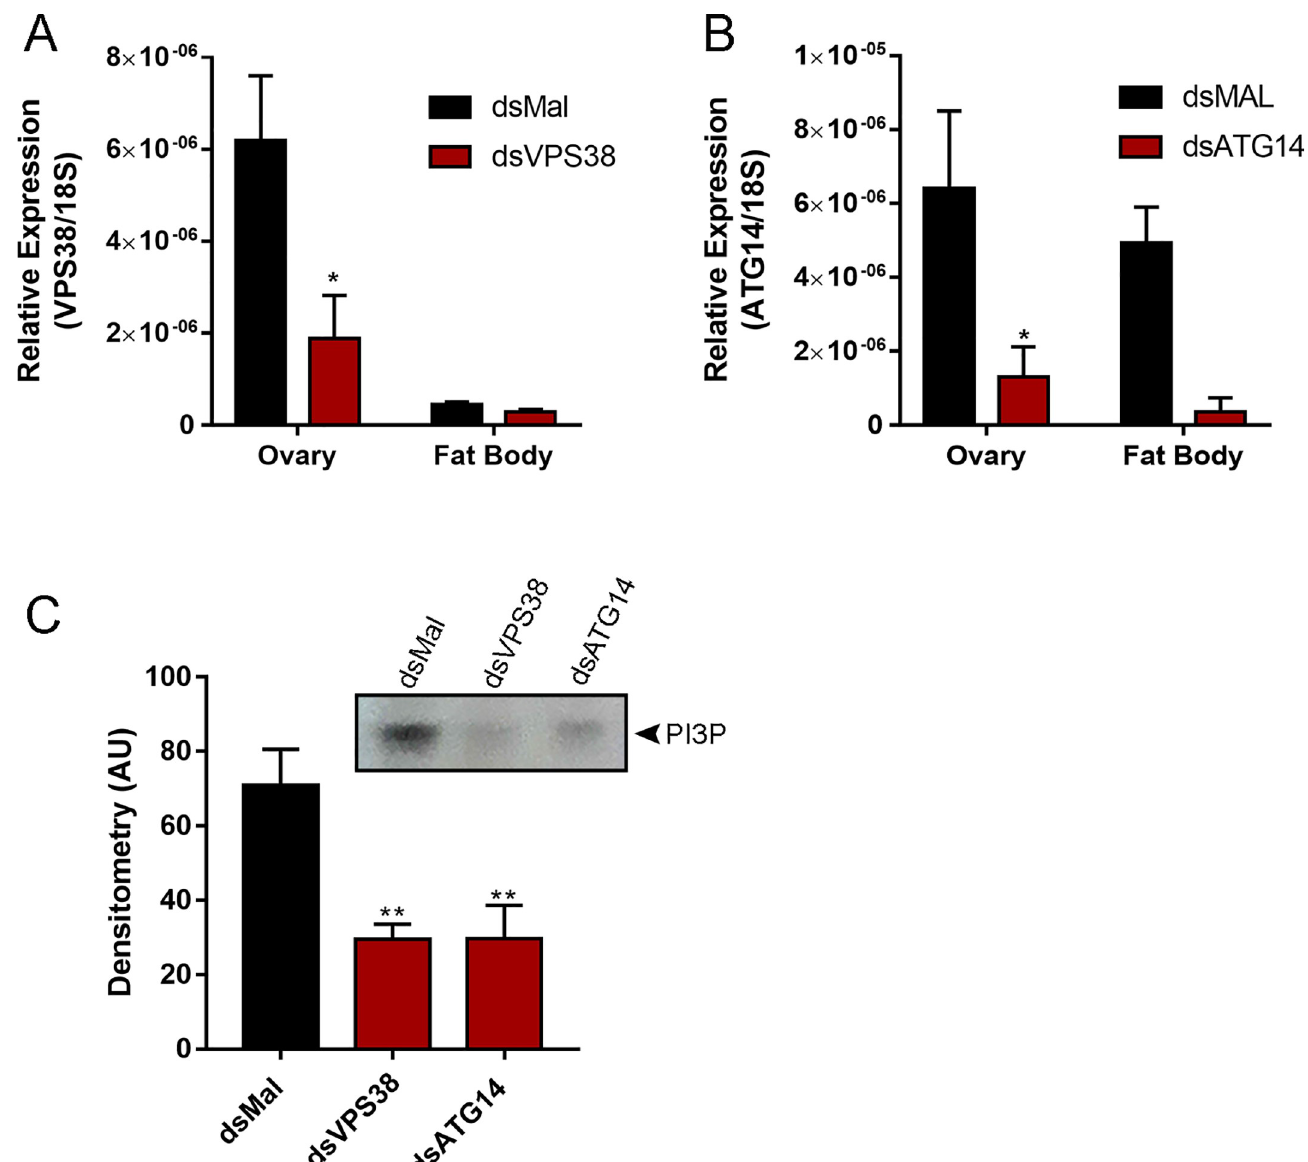
Fig 2. RNAi knockdown of VPS38/UVRAG and ATG14 results in reduced levels of PI3P in the ovary. A-B. RT-qPCR showing the relative expression levels of VPS38/UVRAG and ATG14 in the ovary and fat body of control (dsMal) and silenced females. The organs were dissected 7 days after the blood meal (n = 8). The expression levels of VPS38/UVRAG were reduced by 70% in the ovary and by 50% in the fat body. The expression levels of ATG14 were reduced by 80% in the ovary and by 90% in the fat body. C. Densitometric measurements of PI3P detection by TLC in the chorionated oocytes of control and silenced insects (n = 5). � p < 0.05, �� p < 0.01, One Way